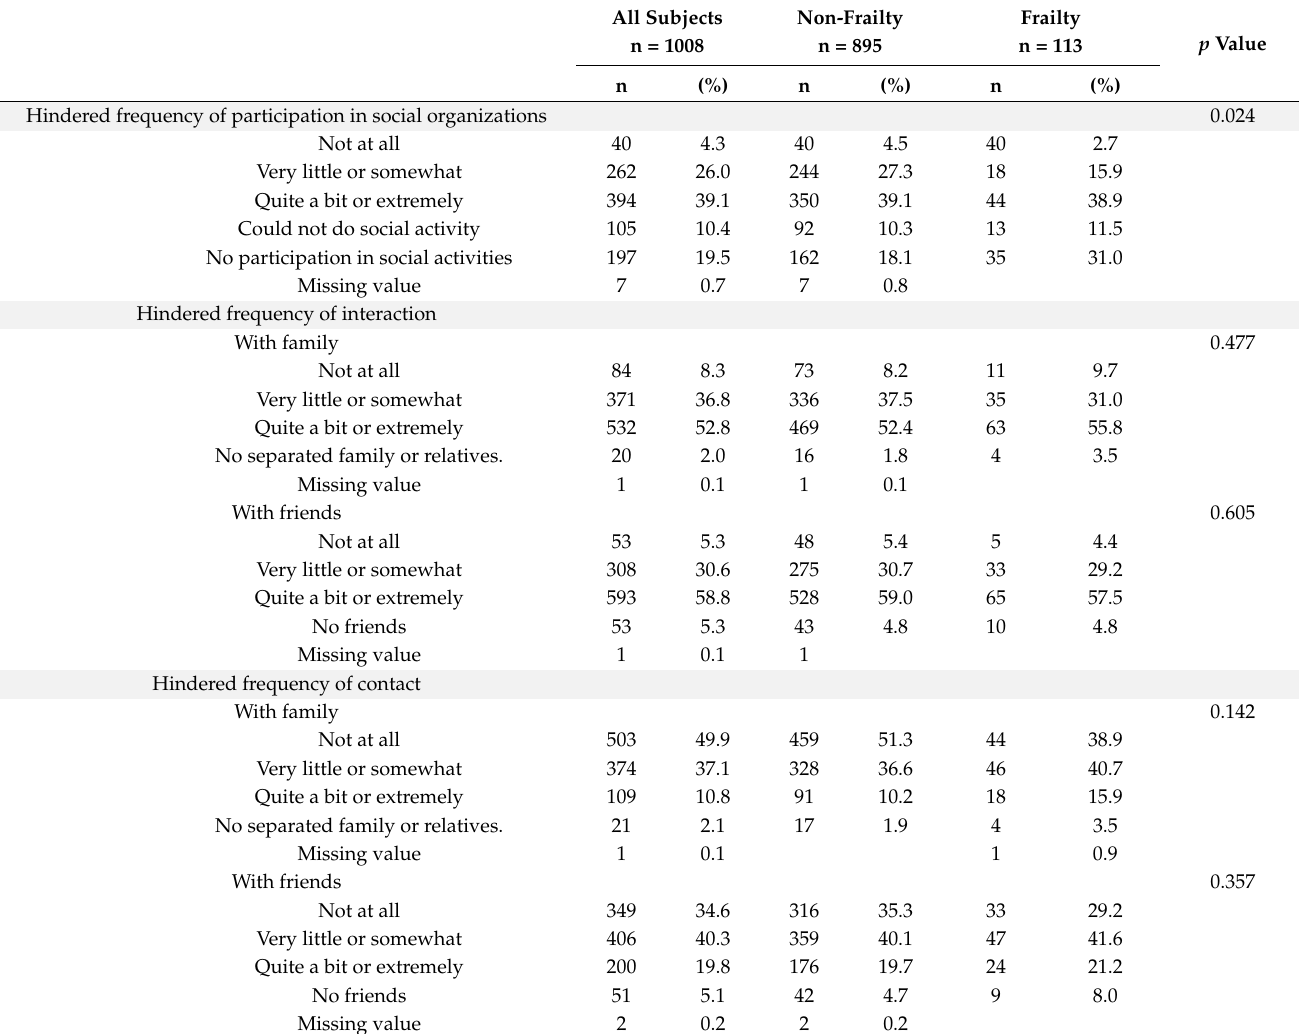
Table 6. Impact of COVID-19 pandemic on social activity during follow-up